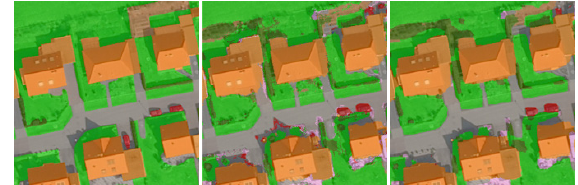
Figure 1: Ground truth (left), result of a RF classification (centre) and of the CRF approach (right). Colours: build. (red), seal. (grey), soil (brown), grass (green), tree (dark green), car (red), others (pink).